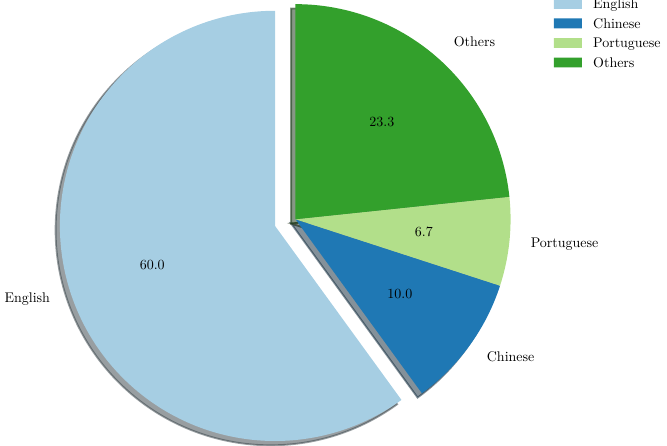
Figure 3. Languages distribution of analyzed works.